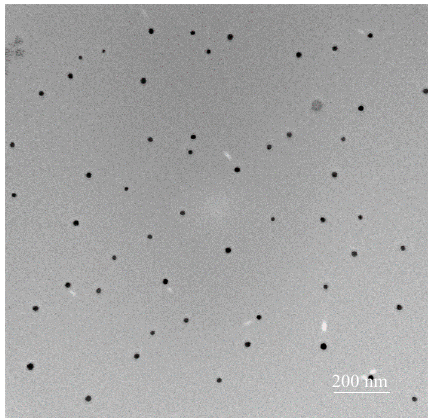
Figure 4. TEM image of synthesized γ -Al 2 O 3 nanoparticles.